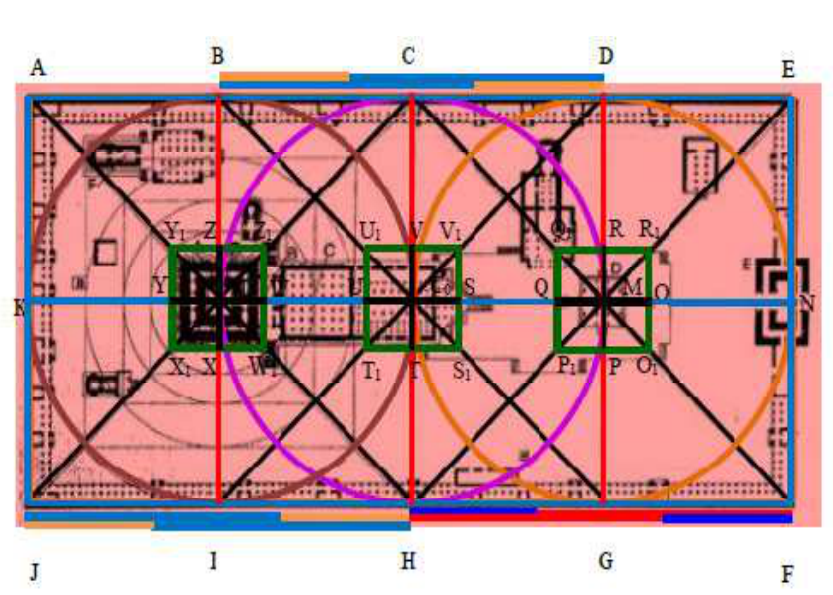
Figure 7. Golden section of The Brihadeeshwarar Temple.